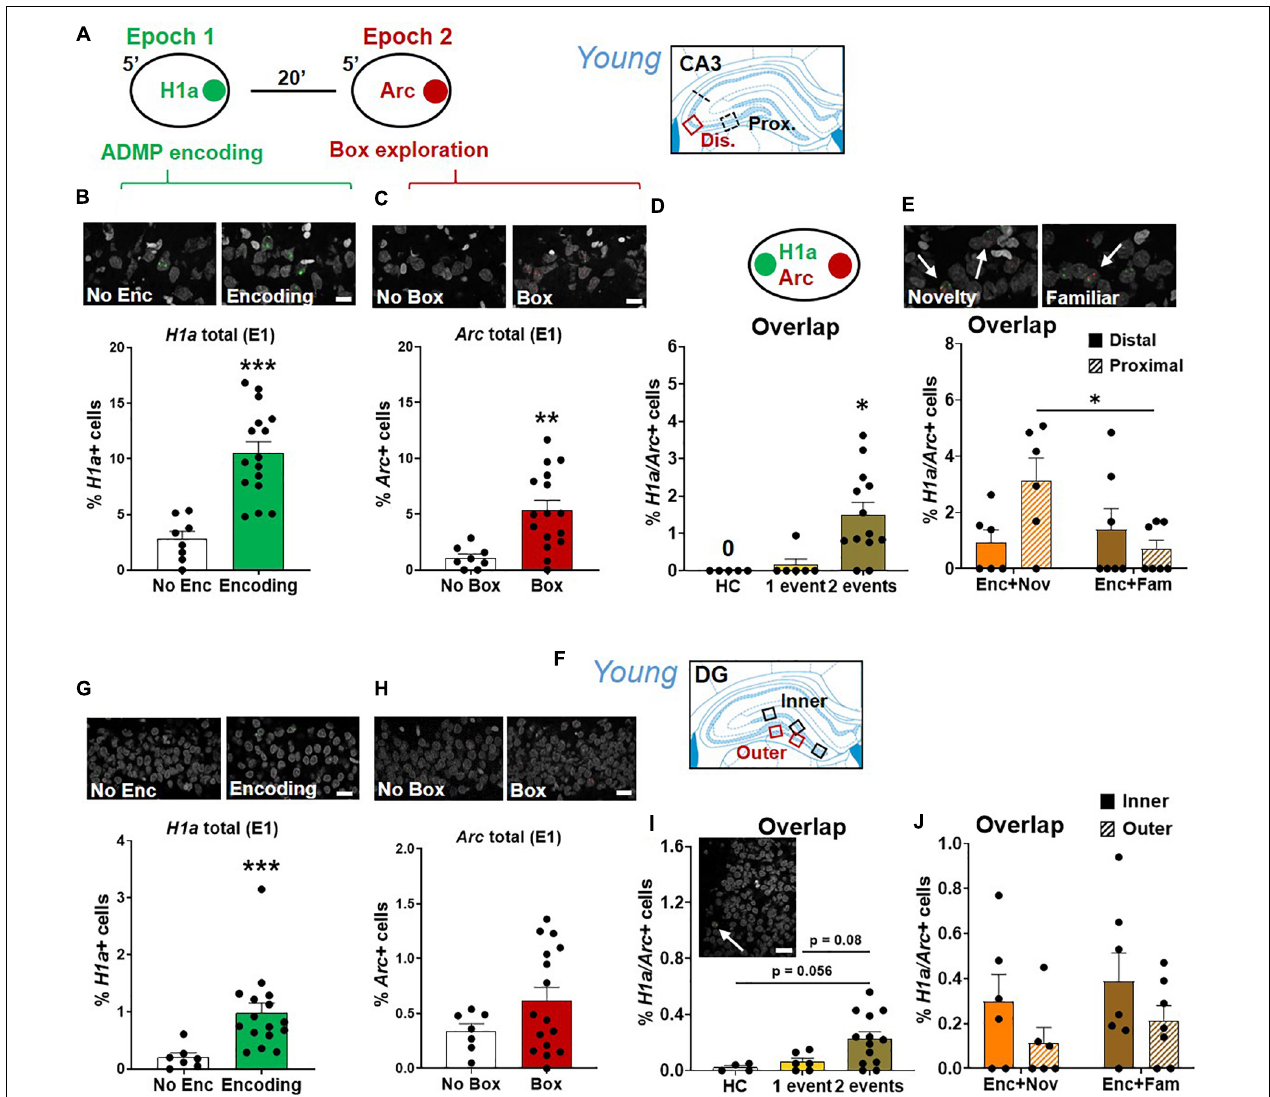
FIGURE 8 | Proximal CA3 and DG activation during behavioral tagging in young rats. (A) The rats could be exposed to ADMP encoding (3 pellets) during epoch 1 for 5 min and then to exploration of a novel box during epoch 2 for 5 min. Images were collected in two areas of CA3. (B) Percentage of H1a + neurons. A scale bar: 10 µ m. The rats exposed to ADMP encoding showed a higher percentage of H1a + neurons than the rats that did not receive encoding (No Enc, the HC rats, and the rats exposed only to novel box exploration) (C) Percentage of Arc + neurons. A scale bar: 10 µ m. The rats that explored a box showed a higher percentage of Arc + neurons than the rats that did not (no box, the HC rats, and the rats exposed to ADMP encoding only). (D) The percentage of H1a / Arc + neurons was highest in the rats receiving two events (Enc + Nov and Enc + Fam, 1 event = the rats exposed only to ADMP encoding or novel box exploration). (E) Percentage of H1a/Arc + neurons between distal and proximal CA3. A scale bar: 10 µ m. The percentage of H1a / Arc + neurons was higher in the Enc + Nov group than in the Enc + Fam group in the proximal CA3. (F) Images were collected in five areas of DG. (G) Percentage of H1a + neurons. A scale bar: 20 µ m. The rats exposed to ADMP encoding showed a higher percentage of H1a + neurons than the rats that did not receive encoding (No Enc, the HC rats, and the rats exposed only to novel box exploration). (H) Percentage of Arc + neurons. A scale bar: 20 µ m. Box exploration did not increase the percentage of Arc + neurons than the rats that did not (no box, the HC rats, and the rats exposed only to ADMP encoding). (I) An example of H1a / Arc + DG neurons. A scale bar: 20 µ m. The percentage of H1a / Arc + neurons was highest in the rats receiving 2 events (Enc + Nov and Enc + Fam, 1 event = the rats exposed to only ADMP encoding or novel box exploration). (J) No difference between inner and outer DG in the percentage of H1a / Arc + neurons activated in the Enc + Nov group. All data are presented as mean ± SEM. * p < 0.05, ** p < 0.01, and *** p <